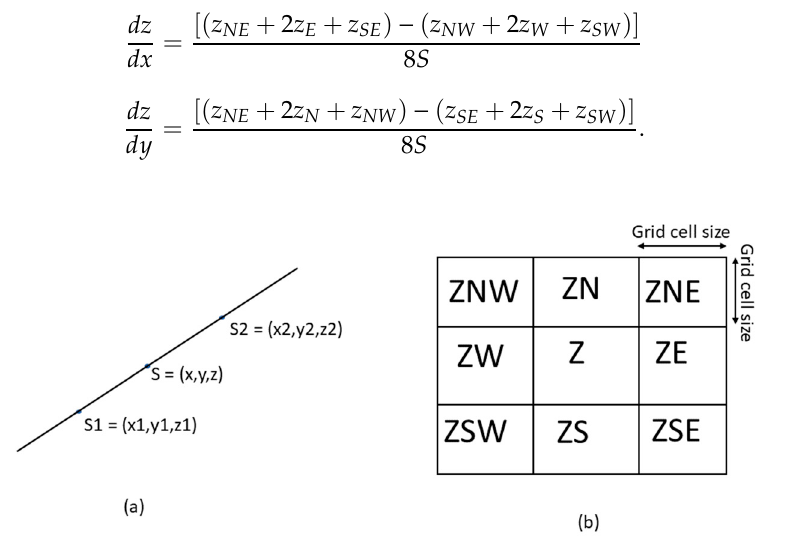
Figure 2. ( a ) Adjacent soundings considered for across-track slope estimation with x , y representing the sounding coordinates and z the depth. ( b ) Neighboring grid cells available for slope estimation. The grid nodes are equally spaced based on the grid cell size.